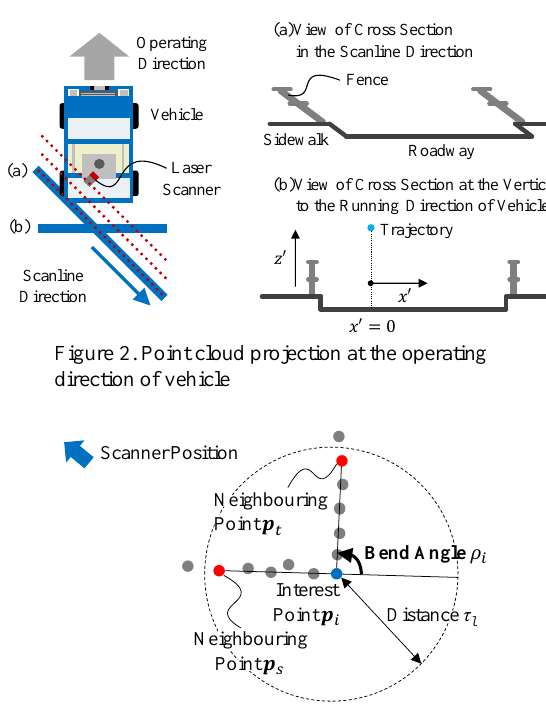
Figure 3. Bend angle. 𝑖 >0, because the shape of three points is concave towards the scanner position